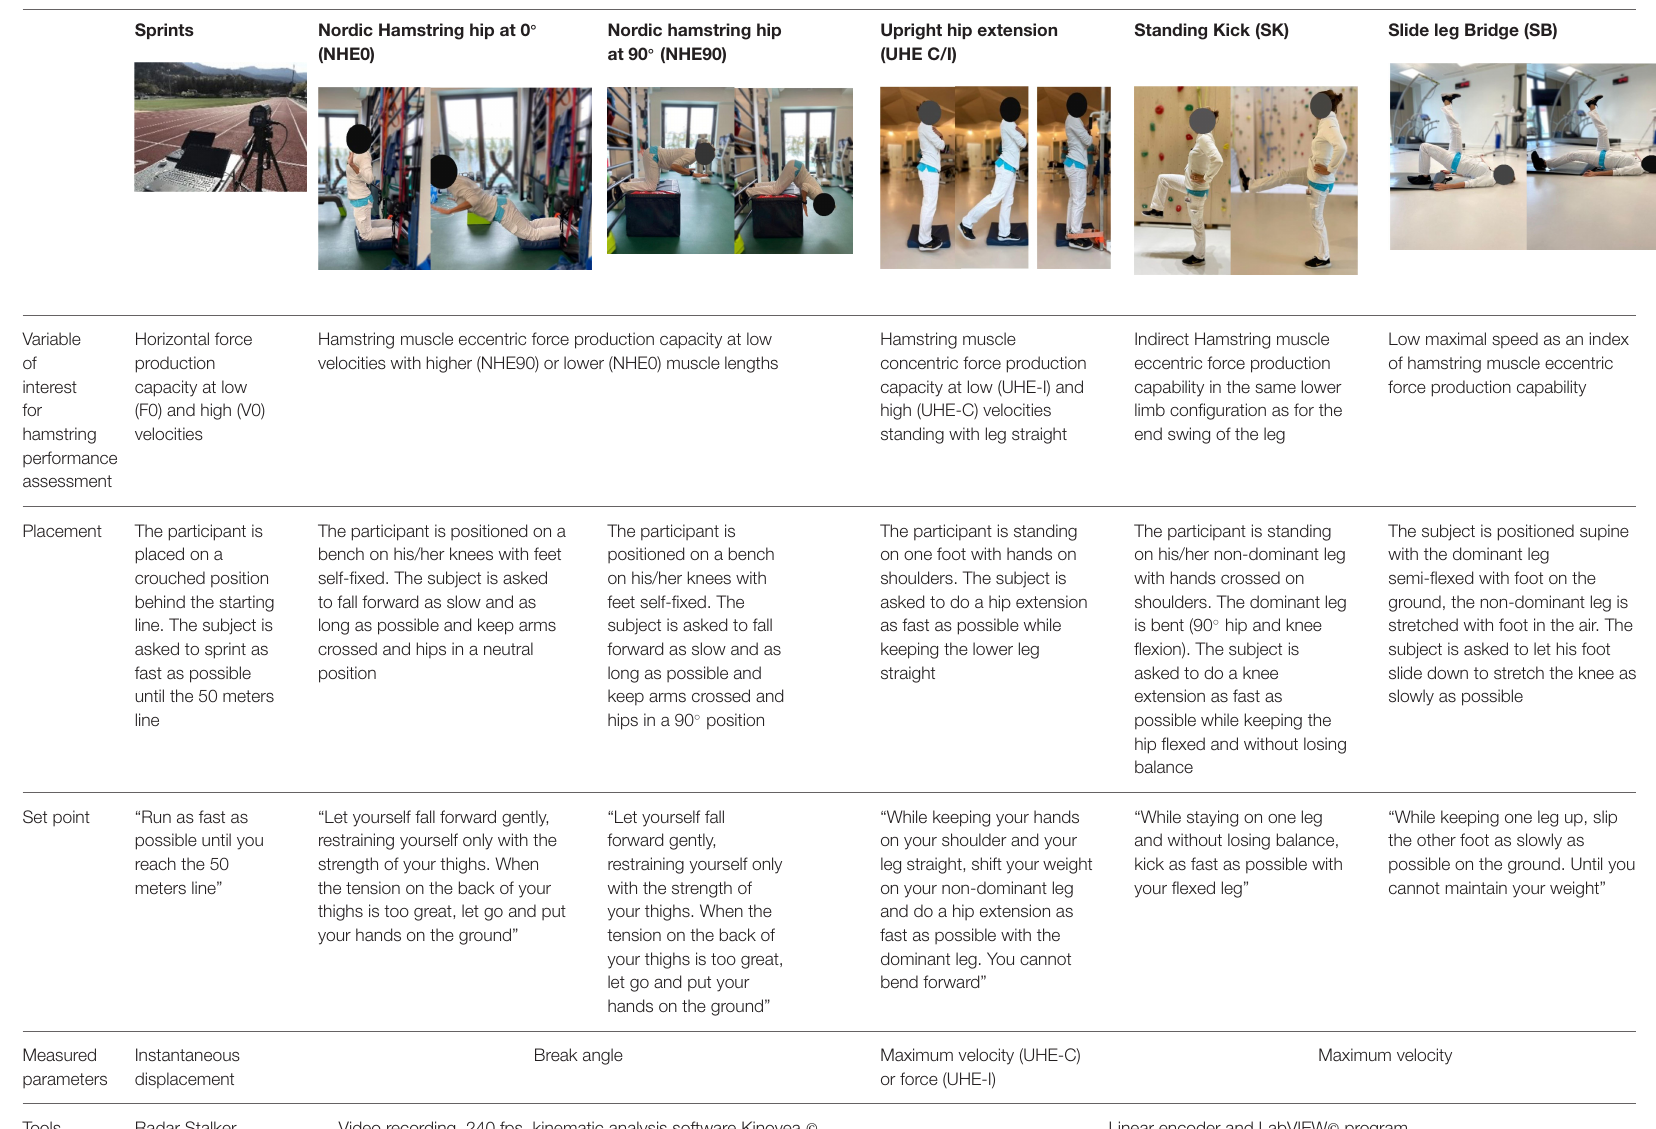
Upright hip extension Standing Kick (SK) Slide leg Bridge (UHE C/I)